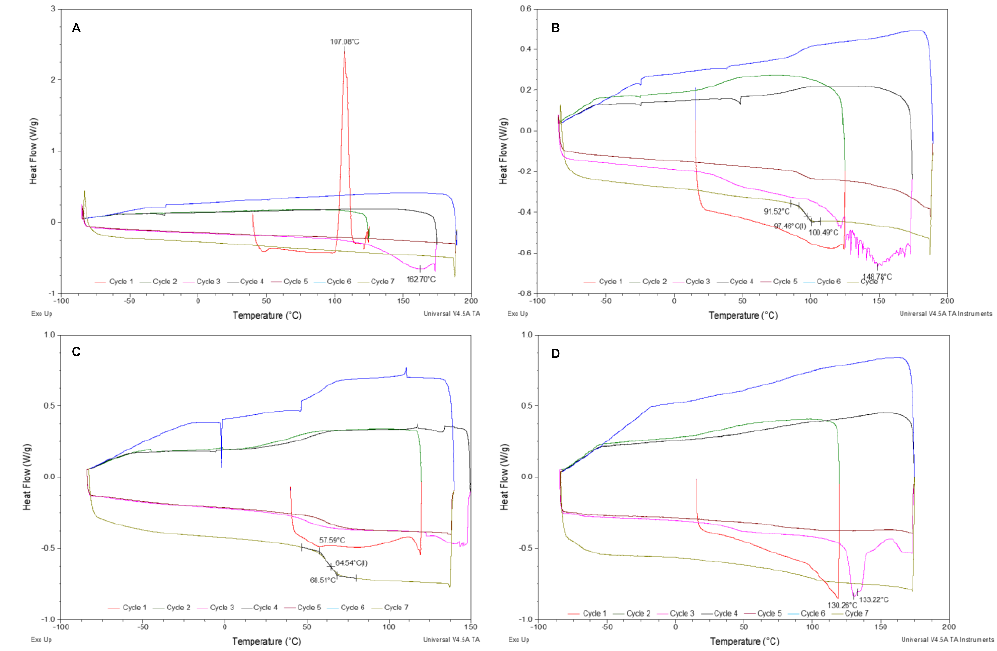
Figure 3. DSC thermograms of ( A ) [TMGH][ALN], ( B ) [TMGH] 2 [ALN], ( C ) [C 2 OHMIM][ALN] and ( D )